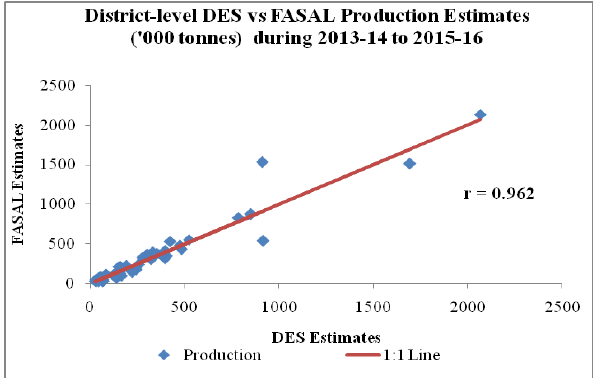
Figure17. District-wise Production ('000 bales) Comparison of Jute DES and FASAL Estimates (Pooled 3 years,